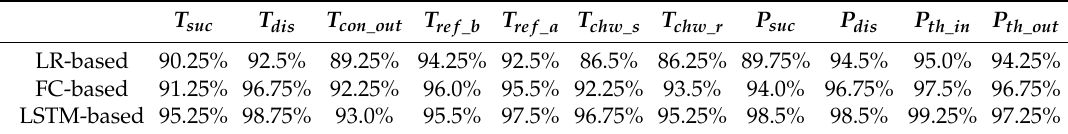
Table 9. Fault diagnosis ratios with negative